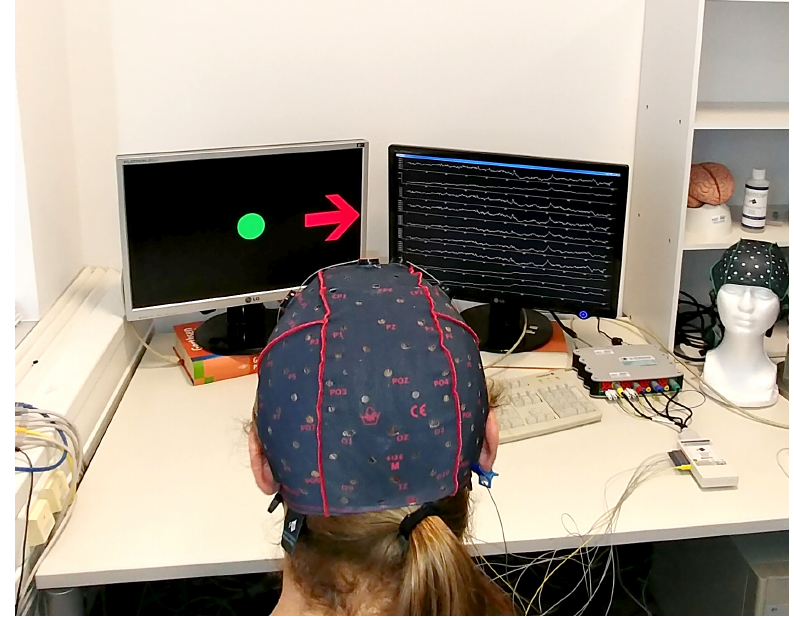
Figure 1. Experimental setup and an example of a recording session of motor imagery-electroencephalography (MI-EEG)